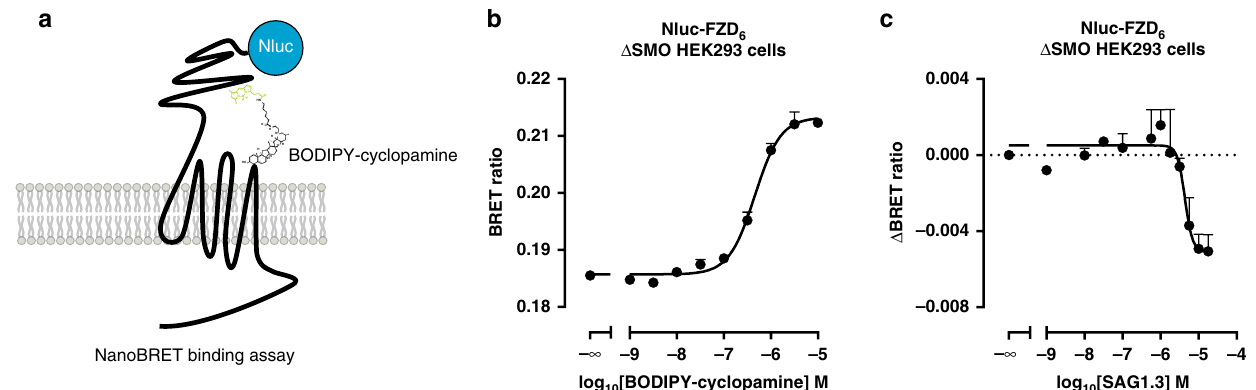
Fig. 2 BODIPY – cyclopamine and SAG1.3 bind to FZD 6 . a The scheme depicts the experimental set up of NanoBRET analysis between the nanoluciferase- tagged FZD 6 and the BODIPY – cyclopamine. b BODIPY – cyclopamine induces a saturable concentration-dependent increase of BRET ratio. The graph presents raw NanoBRET values obtained following 90 min ligand exposure to living Δ SMO HEK293 cells. Data are presented as mean ± s.e.m. of total n =